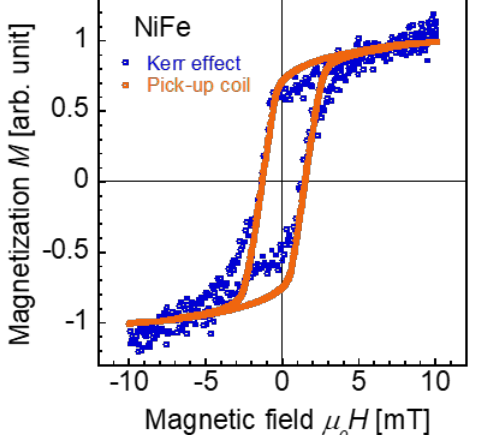
Figure 5. Magnetization curves of the NiFe wire obtained by the MOKE and the voltage induced in the pick-up coil. The diameter and length of the wire are 0.25 mm and 20 mm, respectively. The measurement position is at the center of the wire. An alternating magnetic field of | H ap | = 10 mT/ μ 0 is applied.